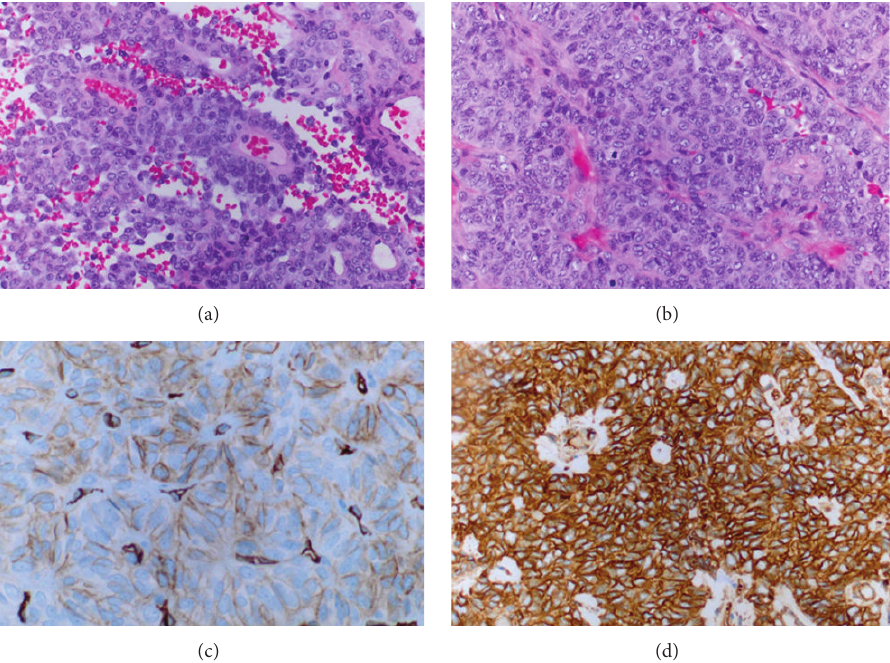
Figure 3: Photomicrograph of tissue sections showing papillary and clear cell morphology with hypervascularity, but no characteristic staghorn appearance (a). Necrosis, intratumoral hemorrhage, nuclear atypia, and frequent mitotic figures were seen (b) and there was patchy and strong CD34 staining (c), as well as strong and diffuse CD99 staining (d).